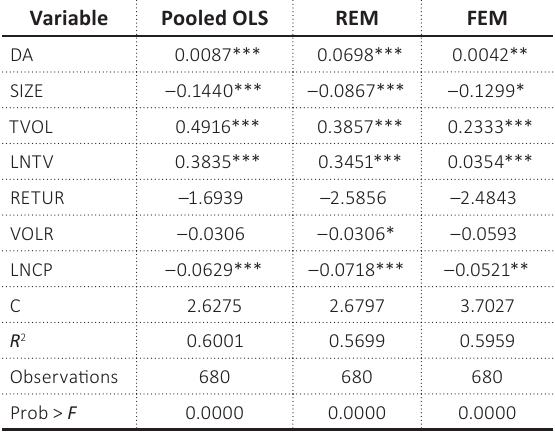
Table 4. Results of regression by pooled OLS, REM, and FEM